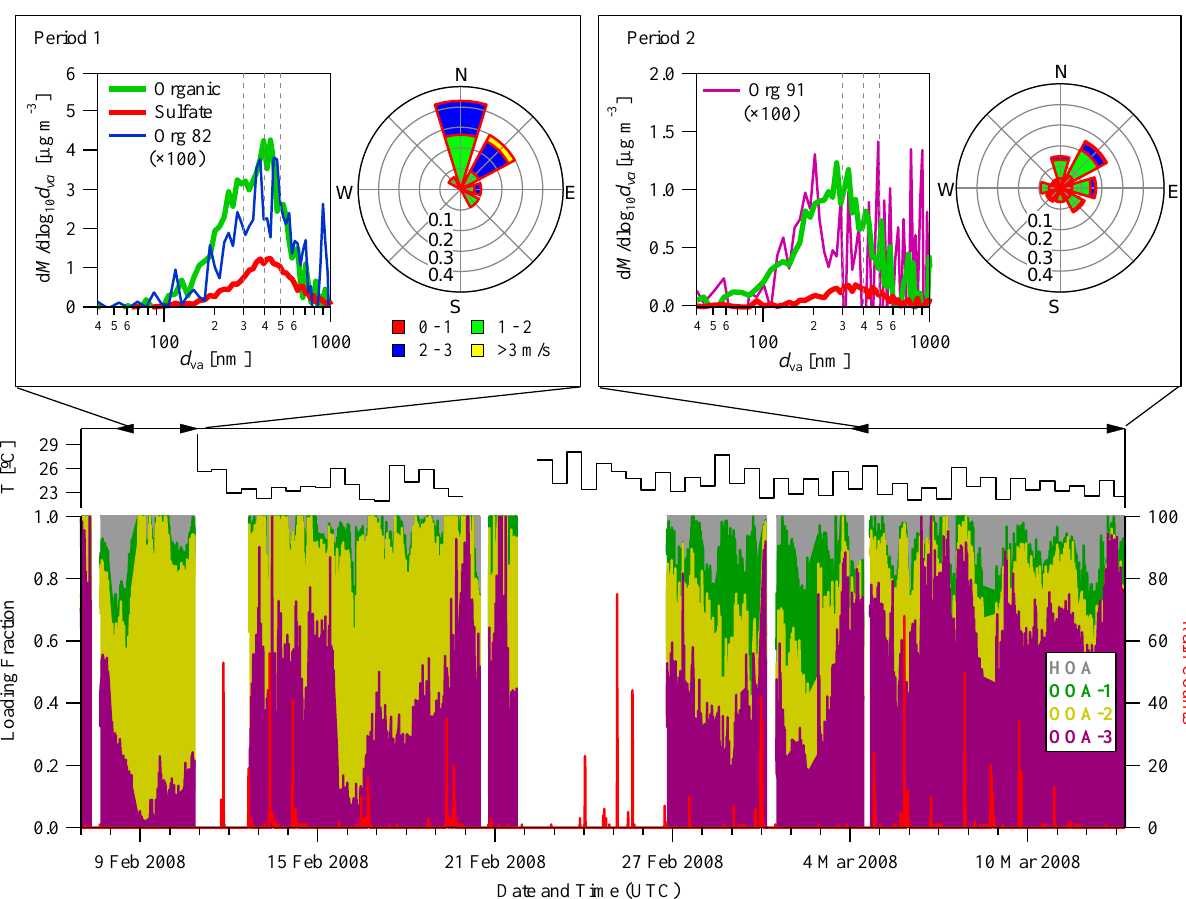
Figure 9. Top: mass–diameter distributions measured by the AMS and the daytime wind rose for the two time periods shown in the bottom panel. Upper section, bottom panel: time series of daily mean temperature measured at the top of the measurement tower TT34. Lower section, bottom panel: time series of the fractional contribution by each of the four statistical factors identified by PMF analysis (left axes) and the rain counts (right axes). Two case periods that differ significantly in the fractional contribution of PMF factors are